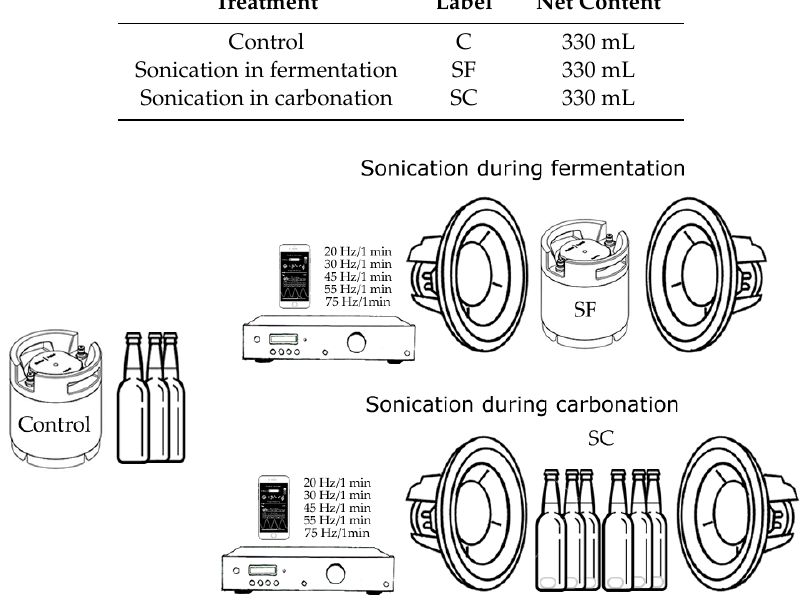
Figure 1. Diagram depicting the treatments developed for the study, where the control was developed with the regular brewing methods, the treatment with sonication during fermentation (SF) consisted of the application of audible sounds to the brewing keg, and the sonication during carbonation (SC) consisted of the application of audible sounds during the in-bottle natural carbonation stage.